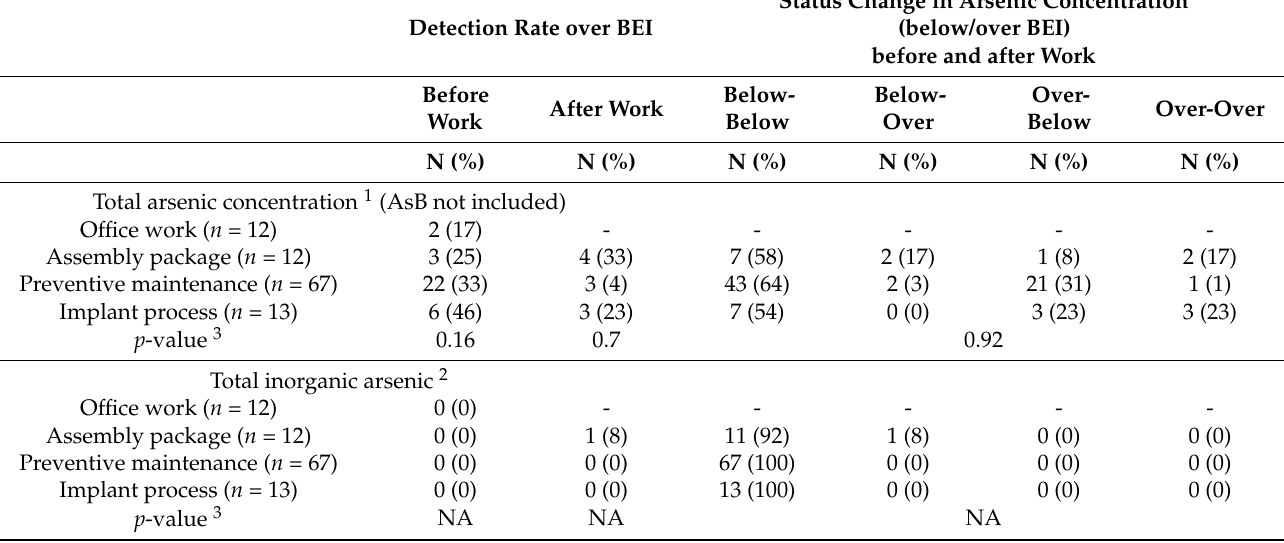
Table 1. Detection rate and the status change in the urinary total arsenic concentration above the biological exposure index (BEI) according to job category. Status Change in Arsenic Concentration Detection Rate over BEI (below/over BEI) before and after Work Below- Below- Over- Before Over-Over After Work Below Over Below Work N (%) N (%) N (%) N (%) N (%)